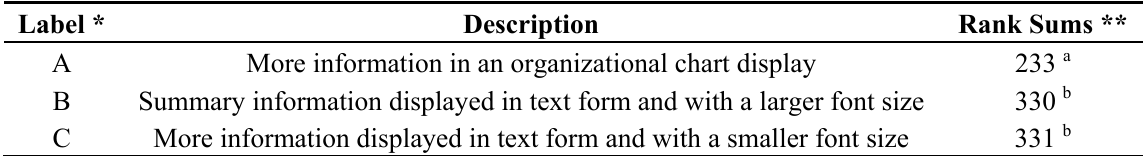
* Figure 2; ** Descending order of preference; Rank sum followed by the same letter are not